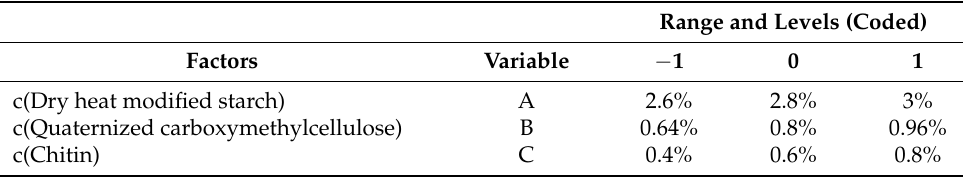
Table 5. Central composite test factor level coding table. Range and Levels (Coded) Factors Variable − 1 0 1 c(Dry heat modified starch) A 2.6% c(Quaternized carboxymethylcellulose)